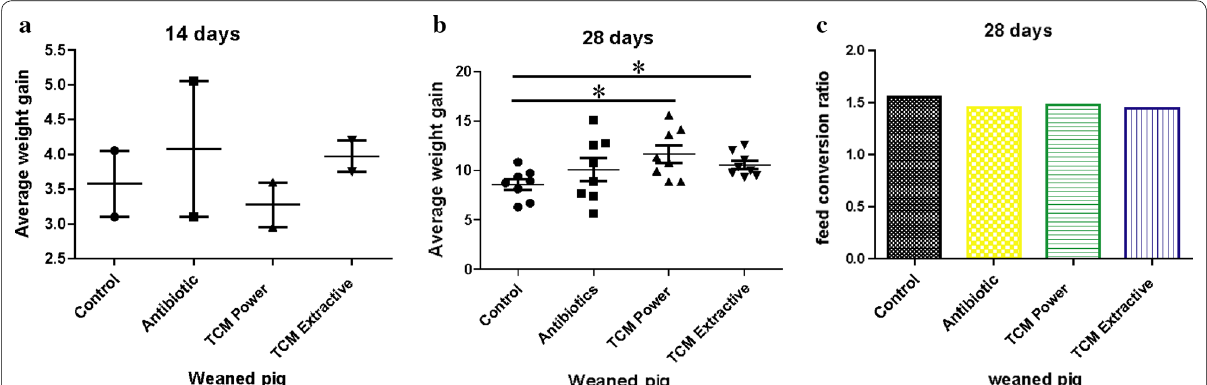
Fig. 1 Average weight gain and feed/meat ratio of weaned pigs. a Average weight gain of weaned pigs at 14 days after the start of the feeding experiment. b Average weight gain at 28 days after the start of the feeding experiment. c Feed/meat ratio of weaned pigs at 28 days after the start of the feeding experiment. (* p <